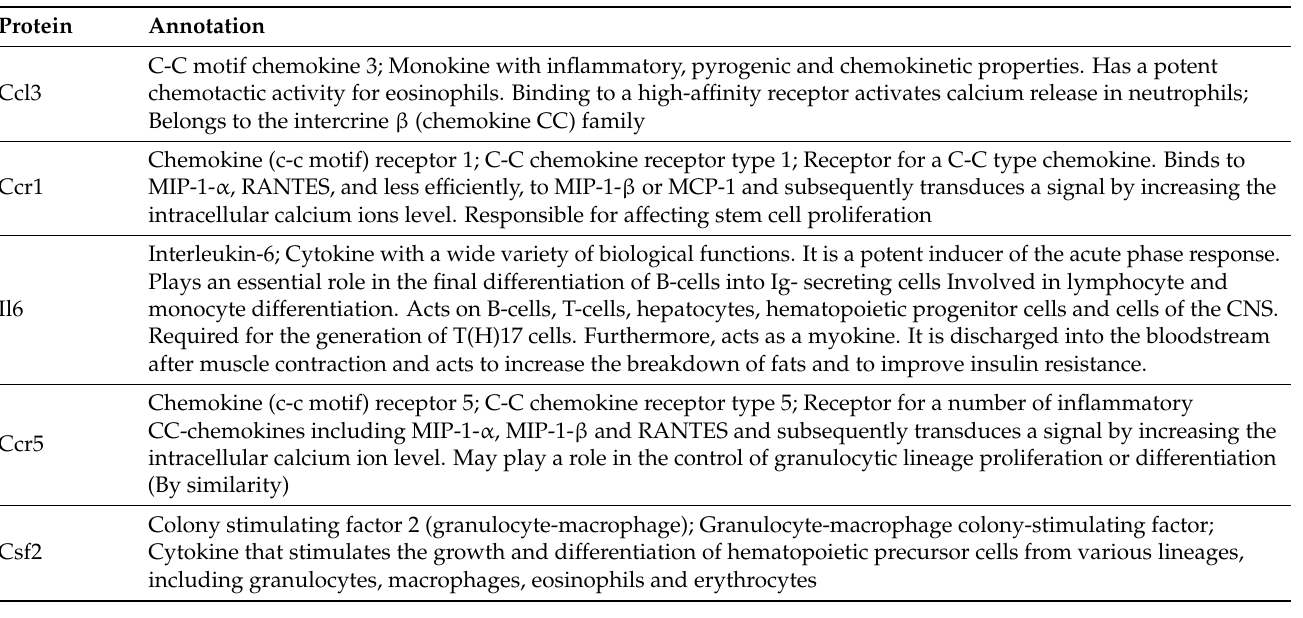
Table 4. Functional annotation of Ccl3 protein association